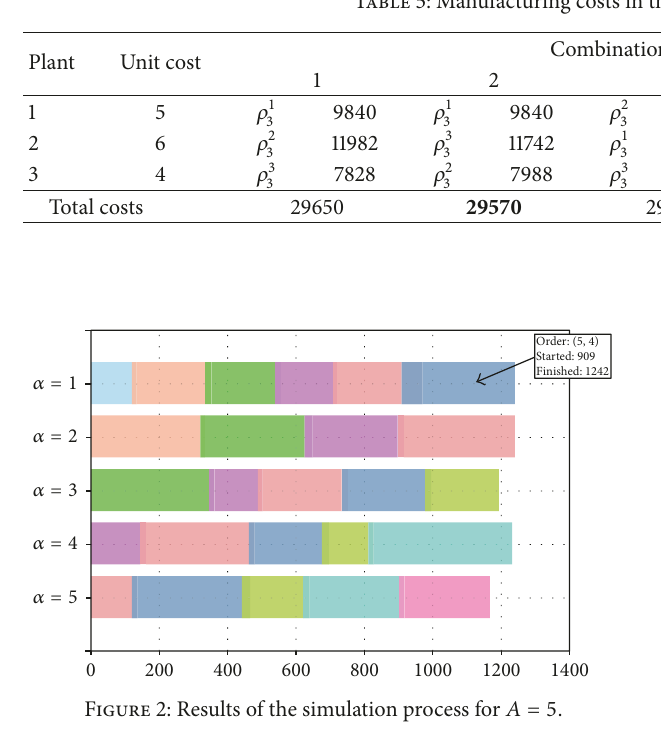
Table 5: Manufacturing costs in the three-plant system (all data).